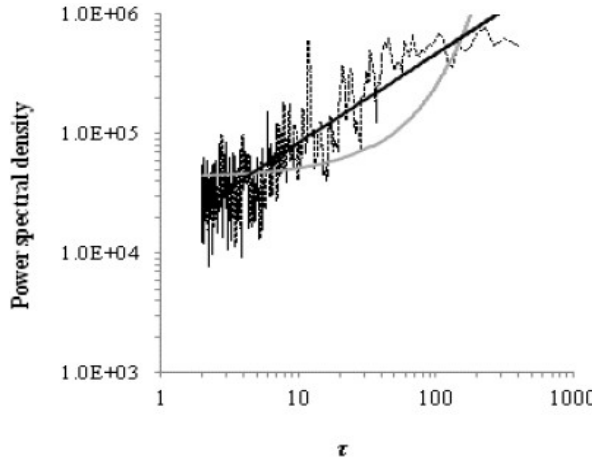
Fig. 5. Power spectral density of the detrended monthly mean LSAT anomalies (over the whole Earth) with the power-law (black line) and the exponential (grey line) fit ( y = 1499 x 0 . 75 with R 2 = 0 . 75 and y = 42963e 0 . 02 x with R 2 = 0 . 32, respectively).